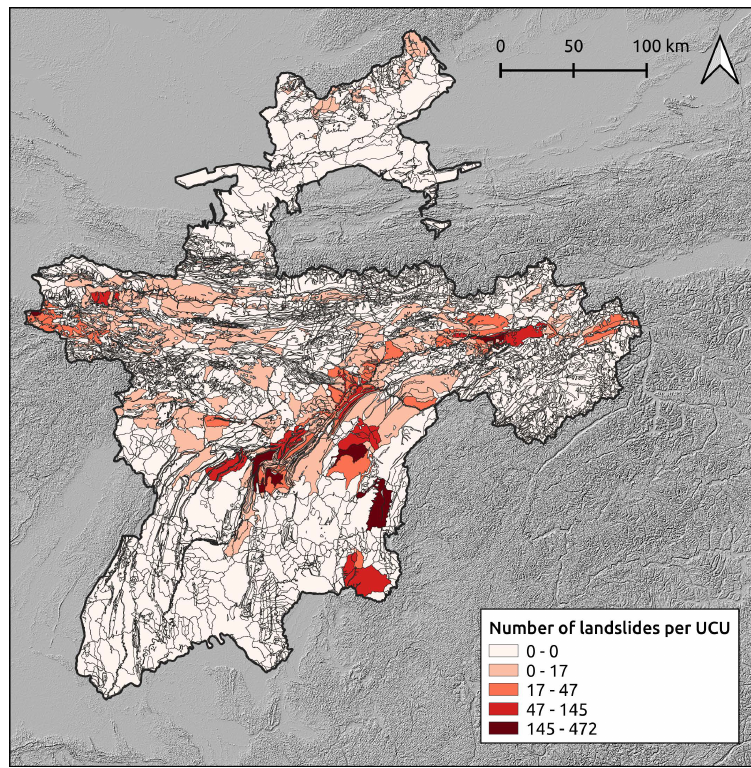
Figure 3. Landslide distribution per